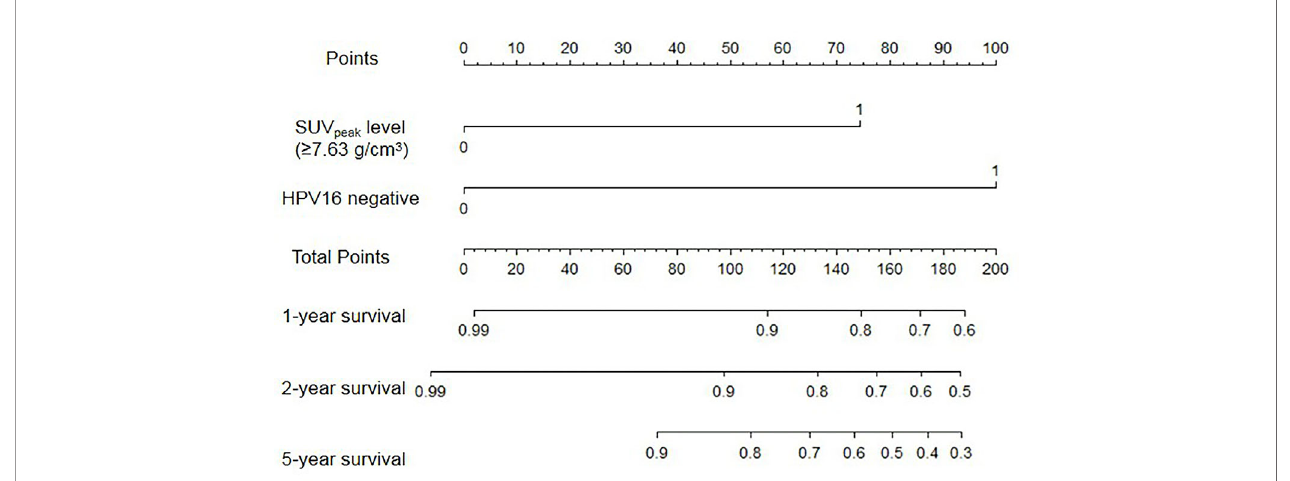
FIGURE 3 | Nomogram for predicting 1-, 2-, and 5-year PFS of cervical cancer.